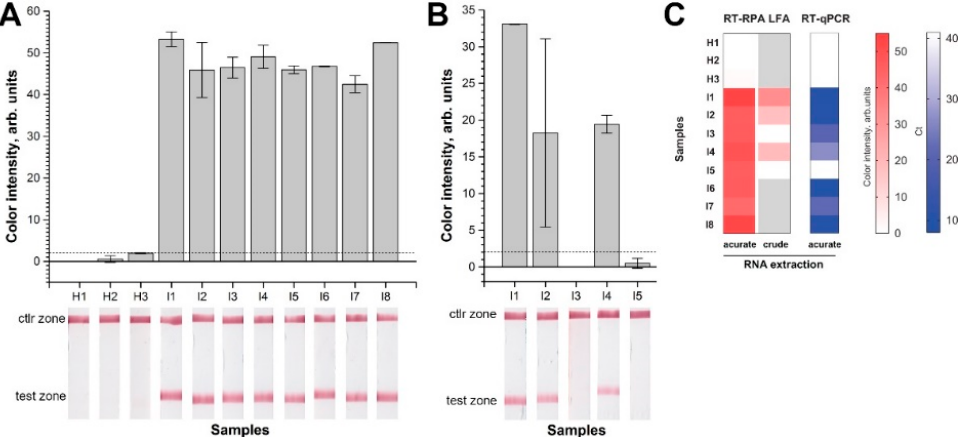
Figure 5. Verification of RT-RPA-LFT test for AMV detection. H—healthy samples, I—infected samples: ( A ) extraction of total DNA/RNA by kit; ( B ) rapid crude extraction of DNA/RNA by grinding; ( C ) comparison of RT-RPA-LFT and RT-qPCR with samples from healthy and infected plants. The results for each sample are presented as distinct squares in the heat maps.